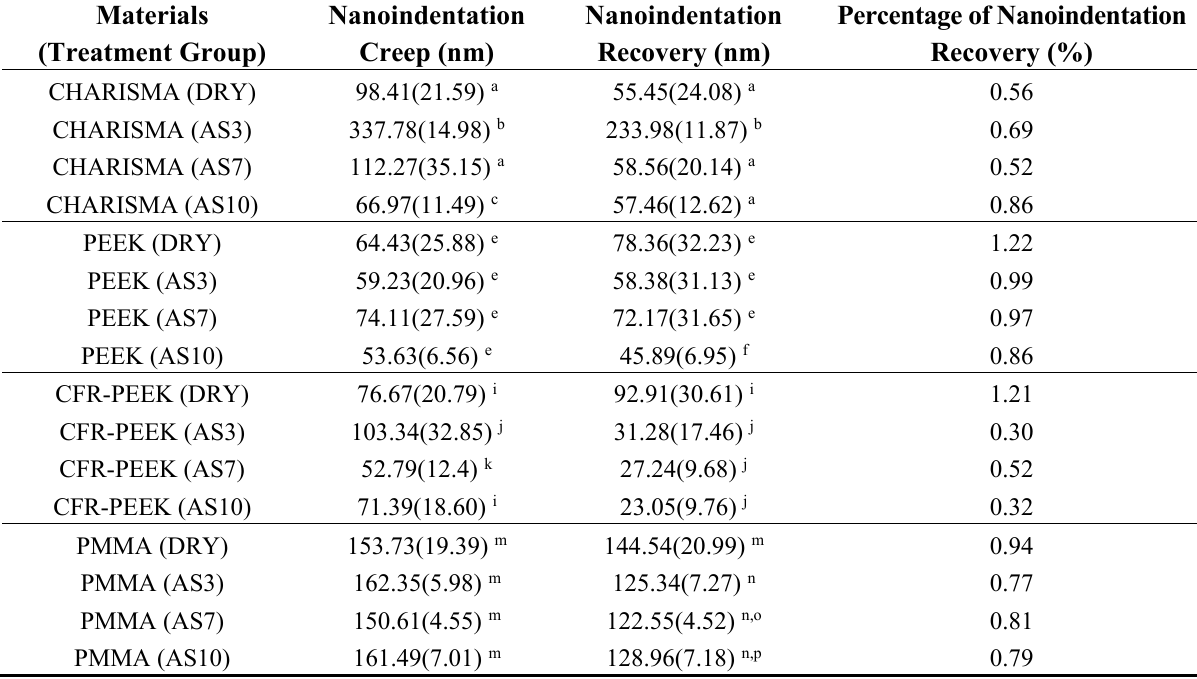
Figure 5. ( a , b ) Plasticity index and percentage of variations, means of 60 indentations (6 indentations each sample) of CHARISMA, PMMA, PEEK, and CFR-PEEK. In ( b ), the negative number on the X axis represents decrease and positive number represents increase. The bars represent standard deviations. Table 3. Mean value (standard deviations) of the nanoindentation creep and recovery parameters of the treatment groups and the control group. Each nanoindentation creep test value is the mean of 30 indentations (3 indentations each